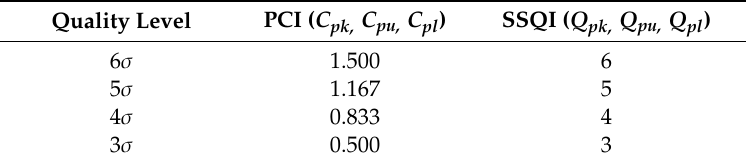
Table 2. Process capability index (PCI) and Six Sigma quality index (SSQI) values corresponding to various quality